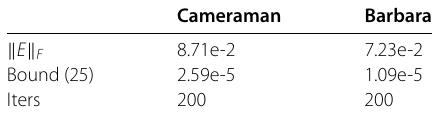
Table 3 Lower bound comparison results of low-rank image